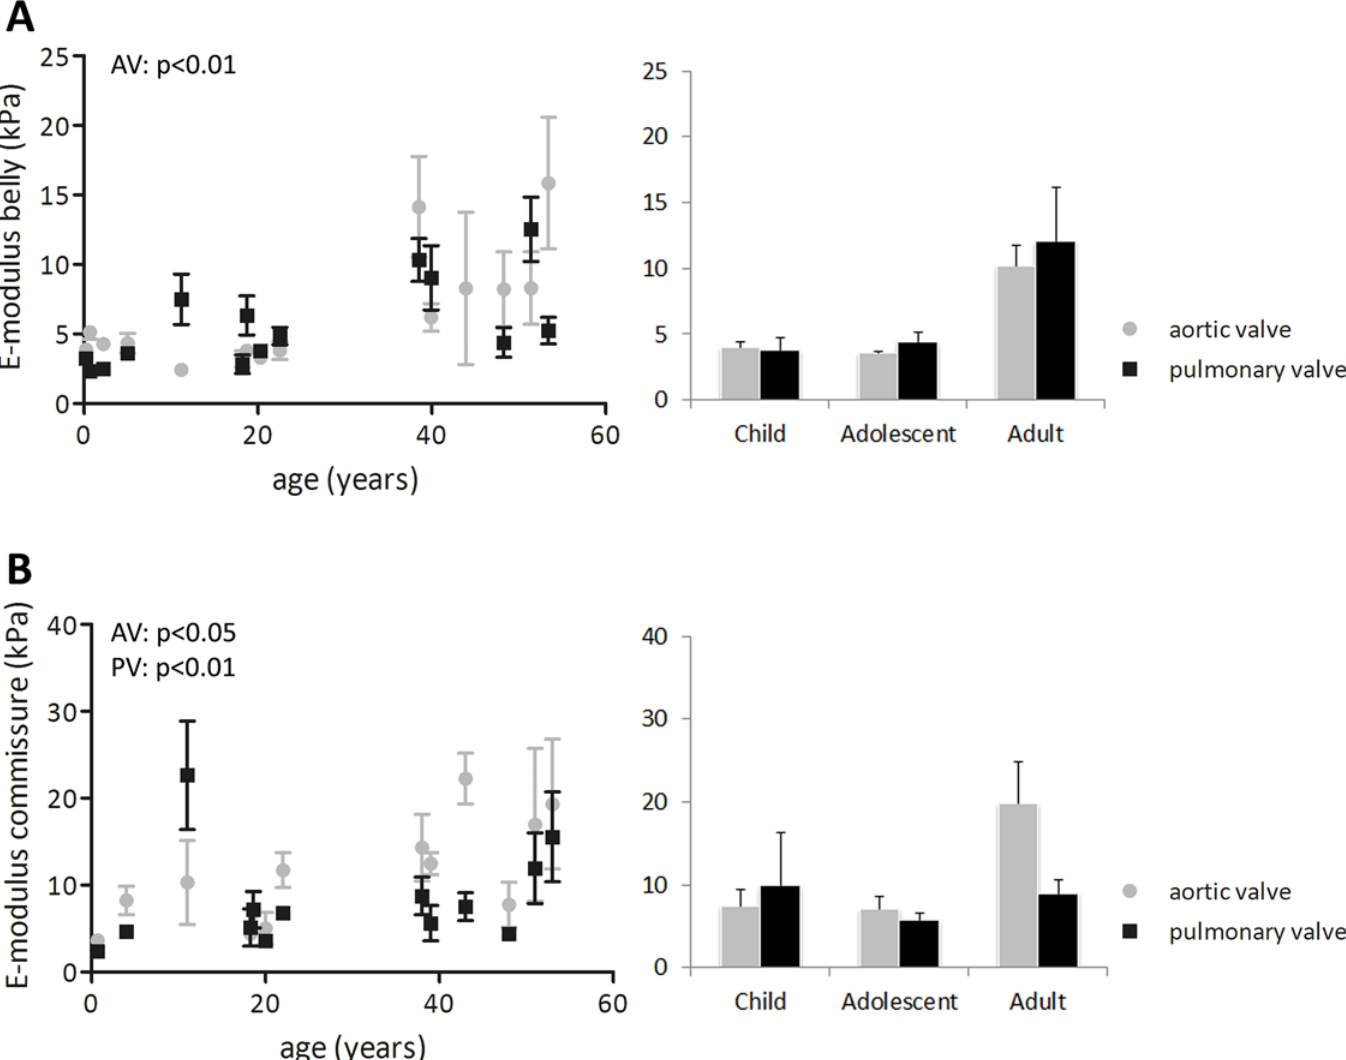
Fig 6. Changes in stiffness at low strains as measured with indentation tests. The stiffness was computed in the belly (A) and commisures (B) (left side: all data points used for correlation analysis with age; at the right side). In the aortic valve, the stiffness in the belly and commissures increase with age, whereas in the pulmonary valve only the commissural stiffness increases with age. In both valves, E-moduli show a steep increase from adolescence to adulthood. Significant differences between groups (p < 0.05) are indicated by paired symbols. AV: aortic valve, PV: pulmonary